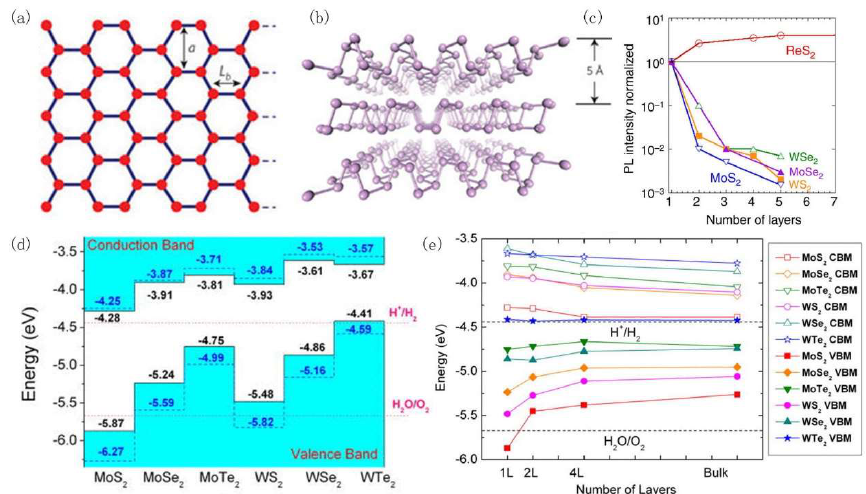
Figure 1. ( a ) Honey comb structure of graphene [31]; ( b ) Atomic structure of black phosphorous [24]; ( c ) Comparison of normalized PL intensity of RS 2 with other transition metal dichalcogenide (TMDC) materials [22]; ( d ) Calculated band alignment of different monolayer TMDC materials [32]; ( e ) Calculated layer dependence of band edge positions of TMDC materials